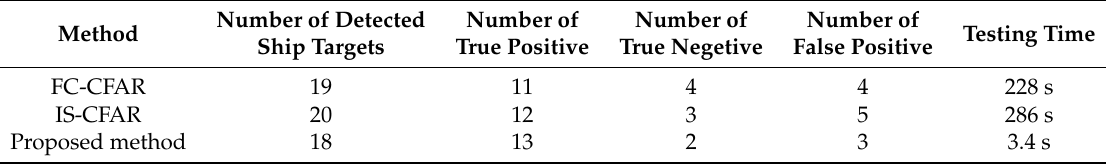
Figure 11. The detection result of Sentinel-1 image. ( a ) Ground truth ( b ) FC-constant false alarm rate (CFAR) ( c ) IS-CFAR ( d ) proposed. The white, green, red, and yellow rectangles represent the ground truth, positive detection, false detection, and missing ships, respectively. Table 8. Detection performance comparison between our method and the reference methods on Sentinel-1